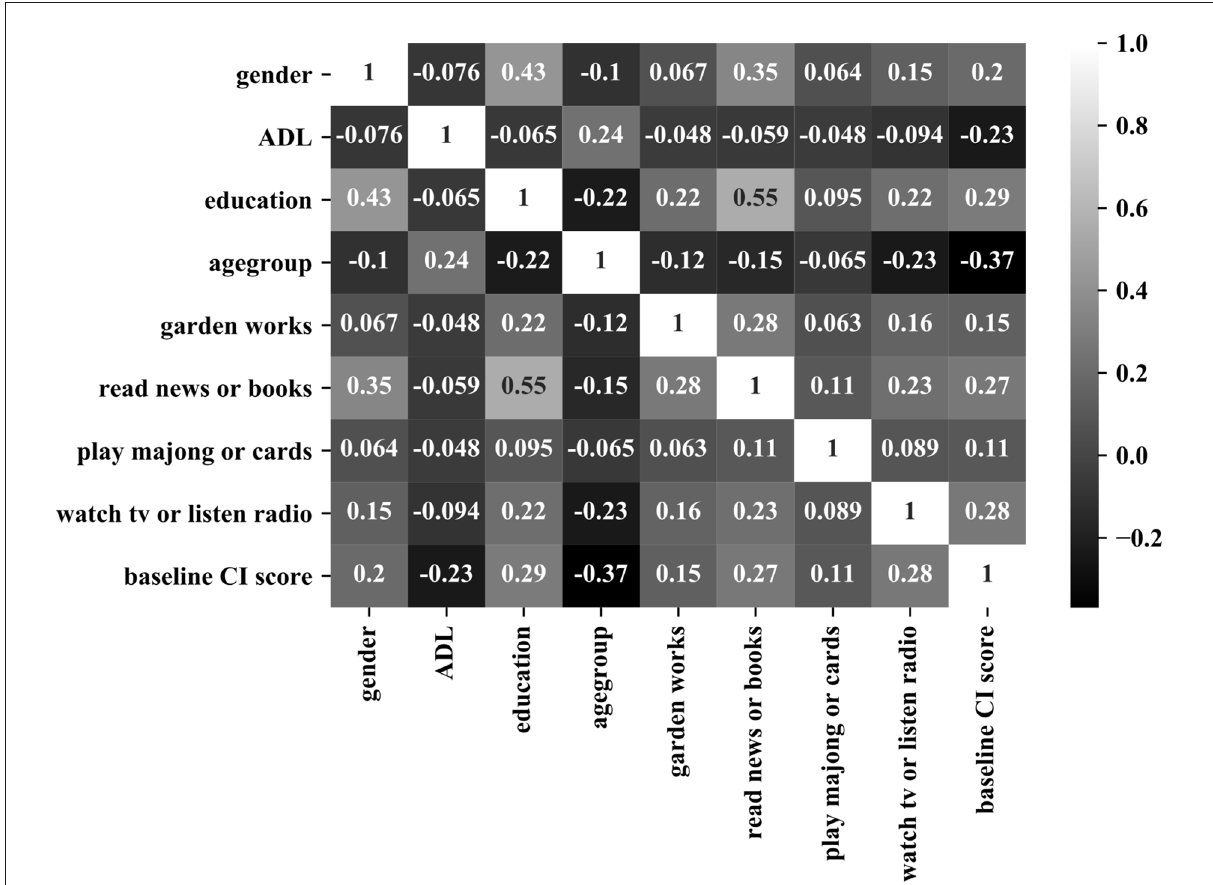
FIGURE3 Pearson correlation among the selected features.